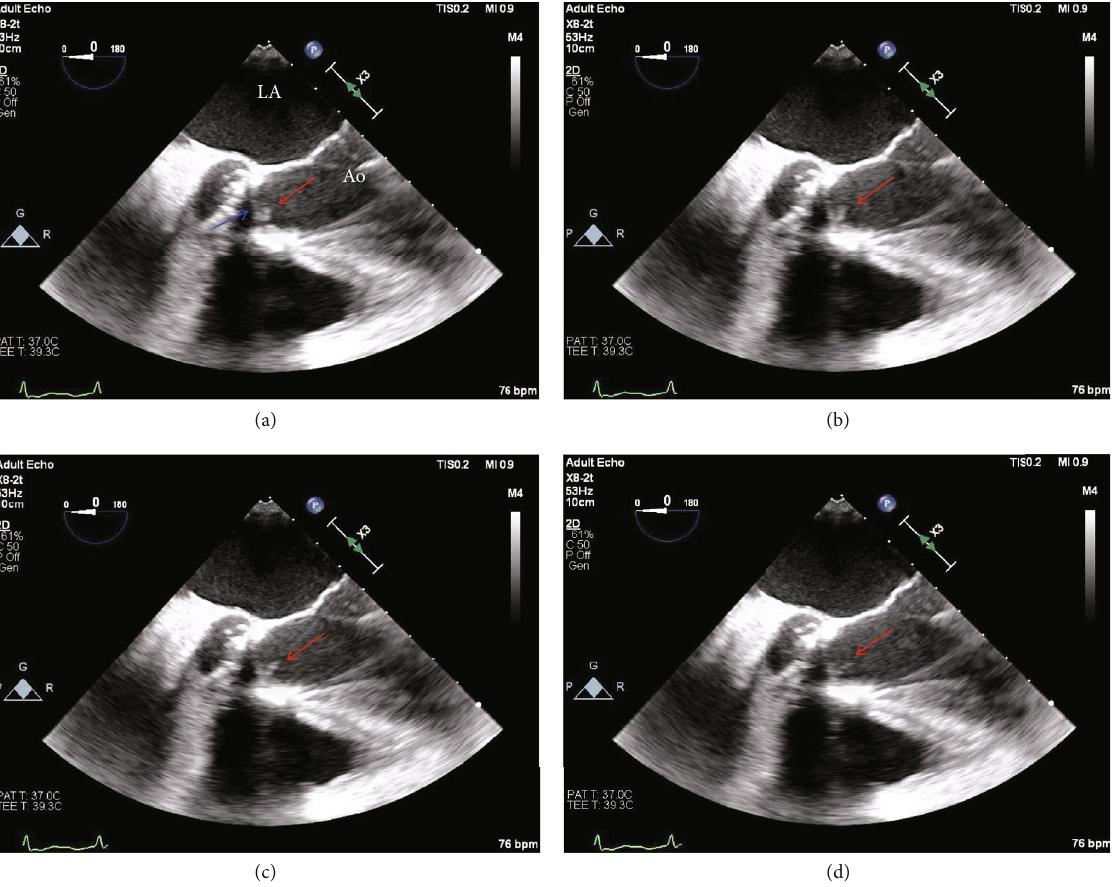
Figure 5: Transesophageal echocardiogram (TEE) midesophageal views (Video 1). Various frames of TEE images showing an elongated and oscillating echogenic structure (red arrow) attached to the right coronary cusp lea fl et of the valve-in-valve TAVR (blue arrow) consistent with an infective endocarditis vegetation (measuring 0.7 cm). No signi fi cant insu ffi ciency or paravalvular extension of infection was detected. No evidence in favor of valvular thrombosis. The other native valves (especially the mitral valve) had no vegetations. LA: left atrium; Ao: ascending